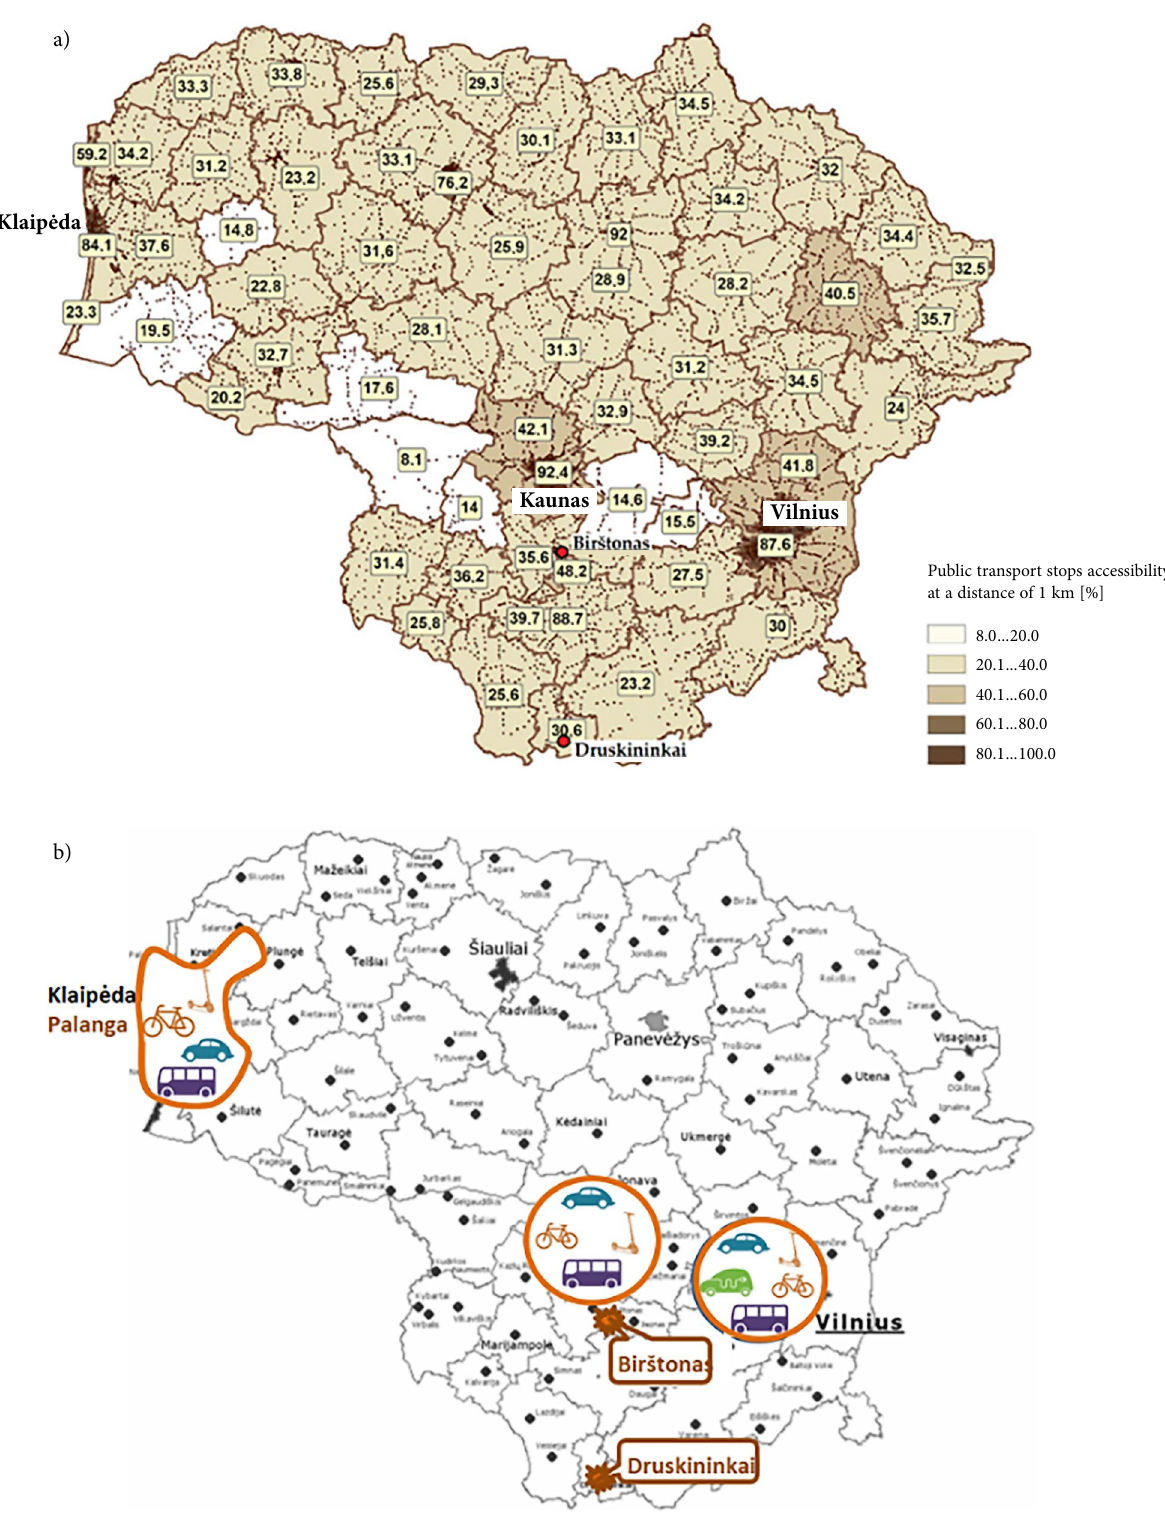
Figure 1. Current mobility situation in Lithuania: a – accessibility of Lithuanian public transport stops at a distance up to 1 km (LR AM 2016); b – sharing transport services availability in different areas (MARA